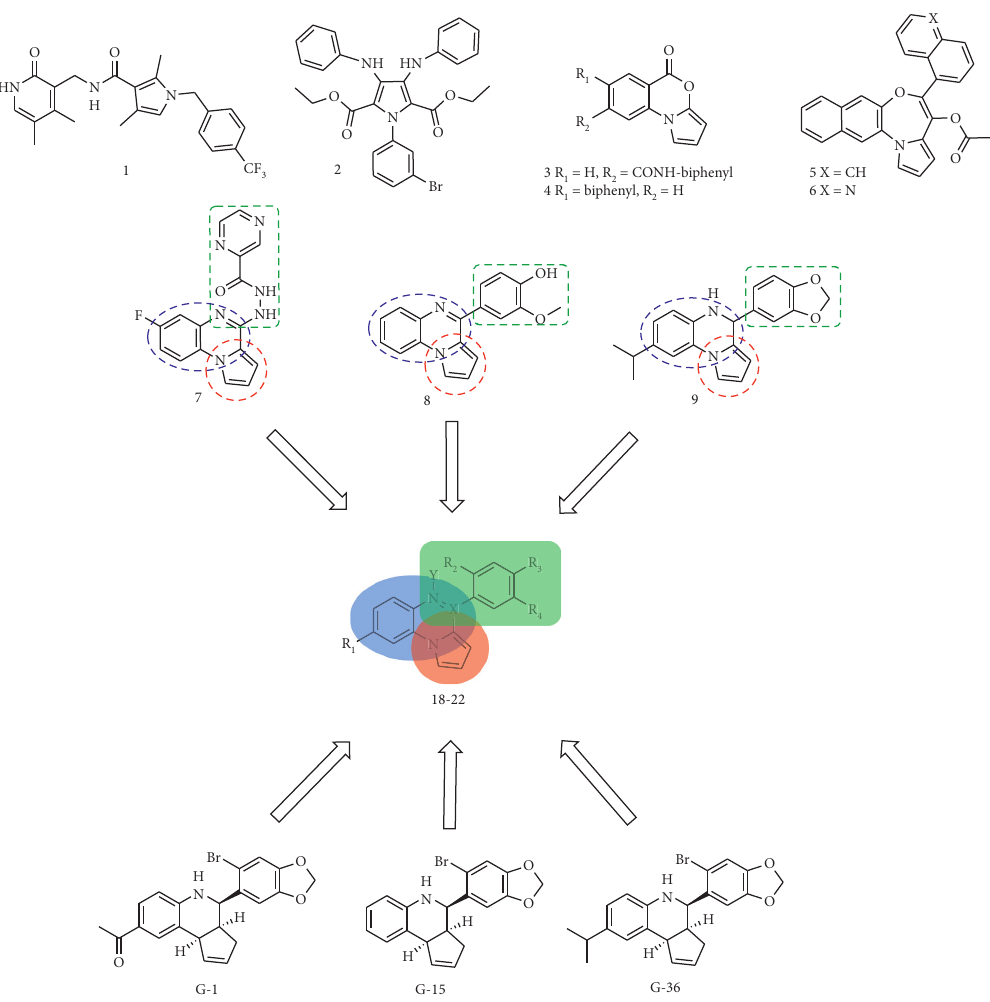
Figure 1: Design of new pyrrolo-[1,2- a